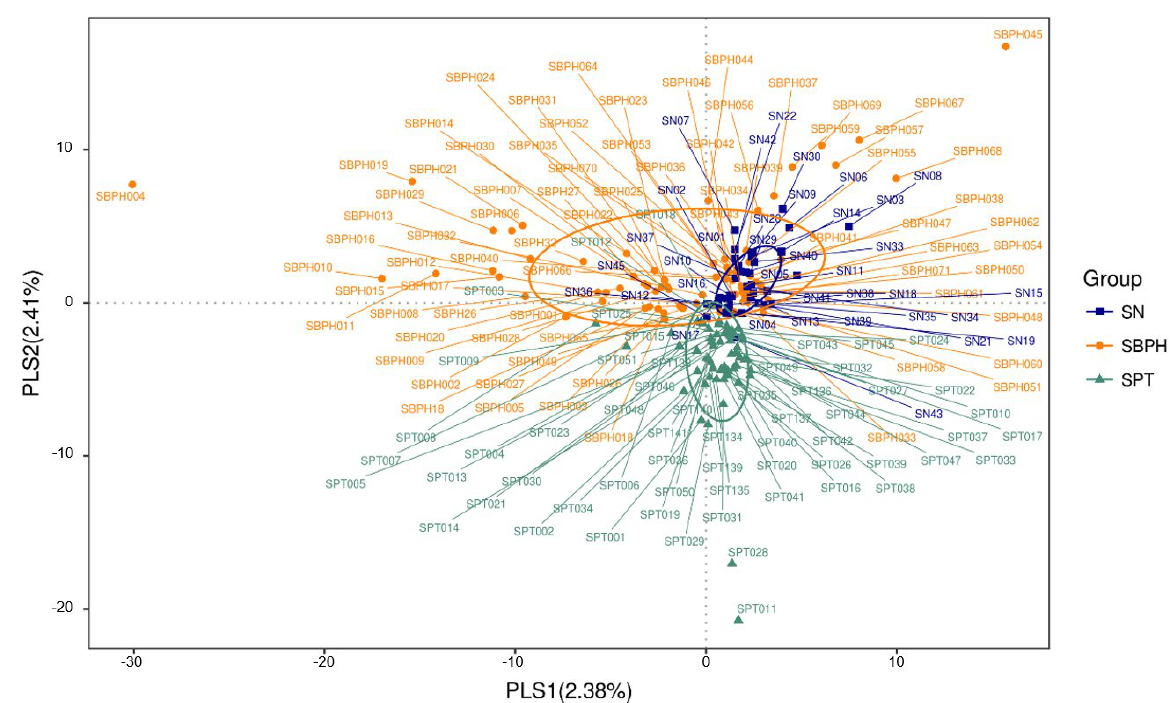
Figure 3. Stool sample PLS-DA plot for visualizing the difference among three groups. Each spot represents a stool sample collected from a project participant. SBPH: Stool from a patient with BPH. SN: Stool from control group. SPT: Stool from a patient with prostate cancer.